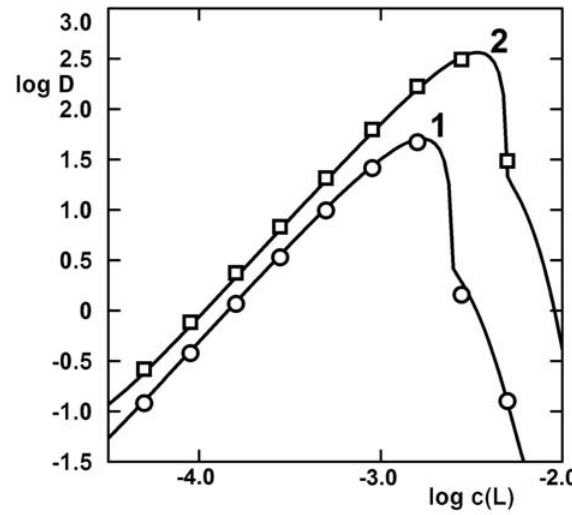
Figure 2. Log D as a function of log c(L), where L = N,N,N’,N’ -te- trabutyl-1,10-phenanthroline-2,9-dicarboxamide, for the system –Am 3+ (microamounts)–nitrobenzene– N,N,N’,N’ -te- water – HNO 3 trabutyl-1,10-phenanthroline-2,9-dicarboxamide (L)–H + B – ; 1 c(HNO ) = 0.05 mol/L, c = 0.0025 mol/L; 2 c(HNO 3 B = 0.005 mol/L. The curves were calculated using the con- mol/L, c B stants given in Table 6.